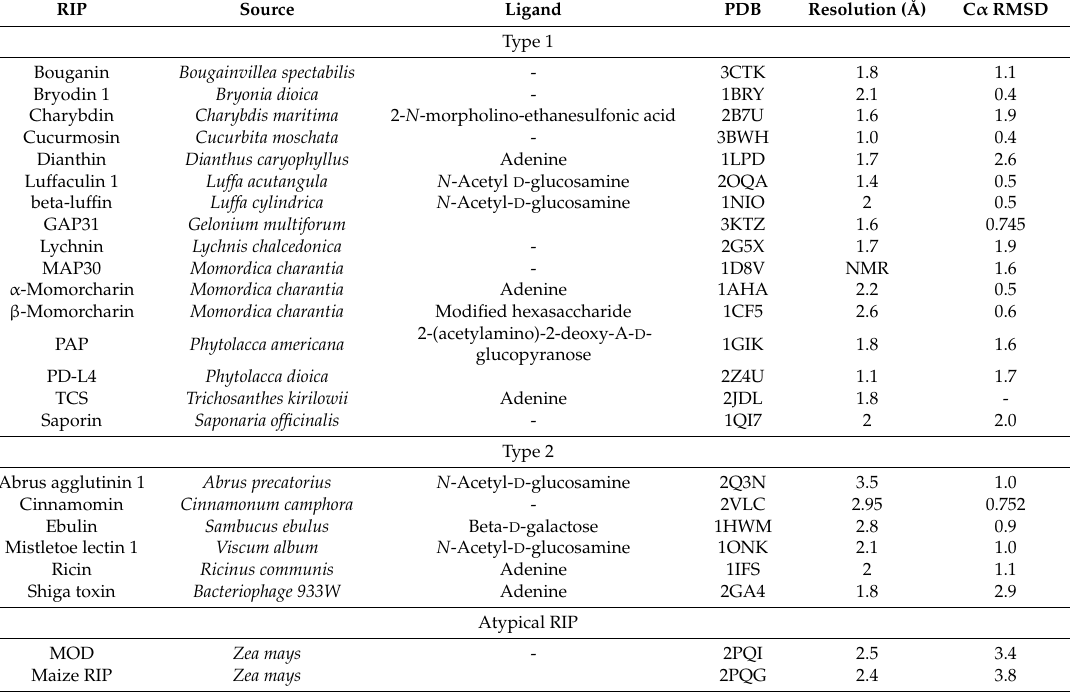
Table 1. Available structures of representative RIPs and their similarity in comparison with trichosanthin